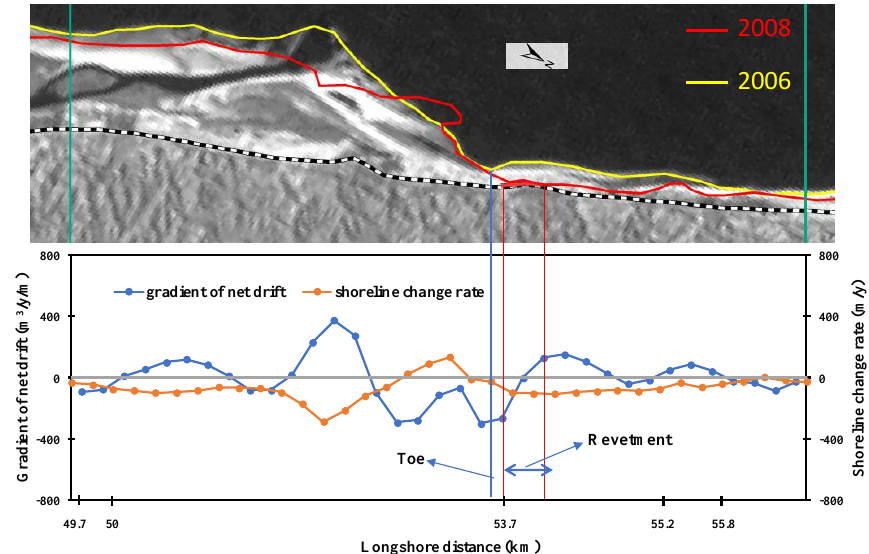
Figure 26. Relation between gradient of the net drift and shoreline change rates from 2006–2008. A positive (negative) gradient induces erosion (accretion).